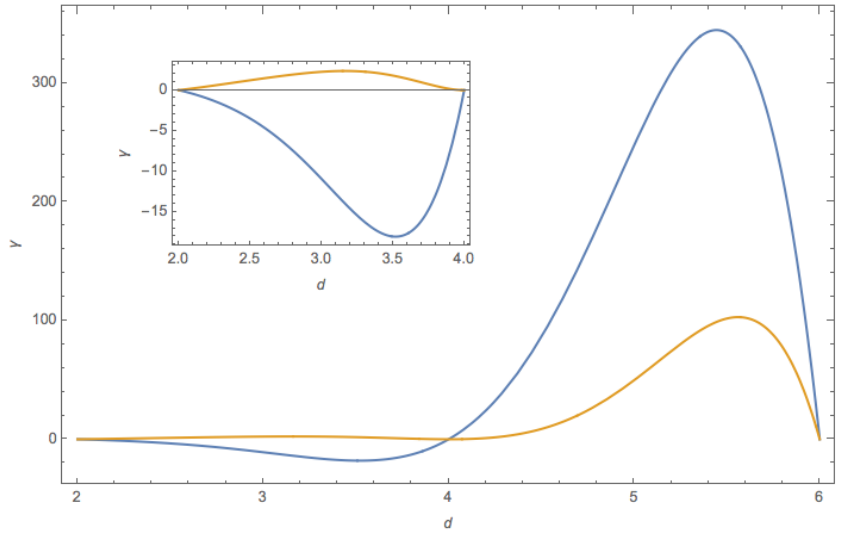
Figure 1 . (cid:13) 1 ( d ) (blue) and (cid:13) 2 ( d )